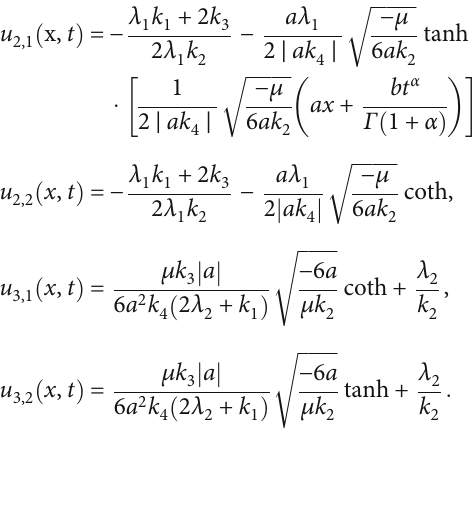
ffiffiffiffiffiffiffiffiffi μ